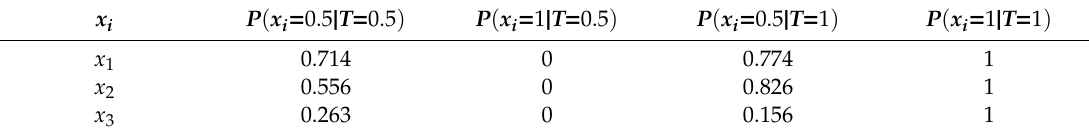
Table 5. Posteriori probability of leaf nodes when fault state is 0.5 and